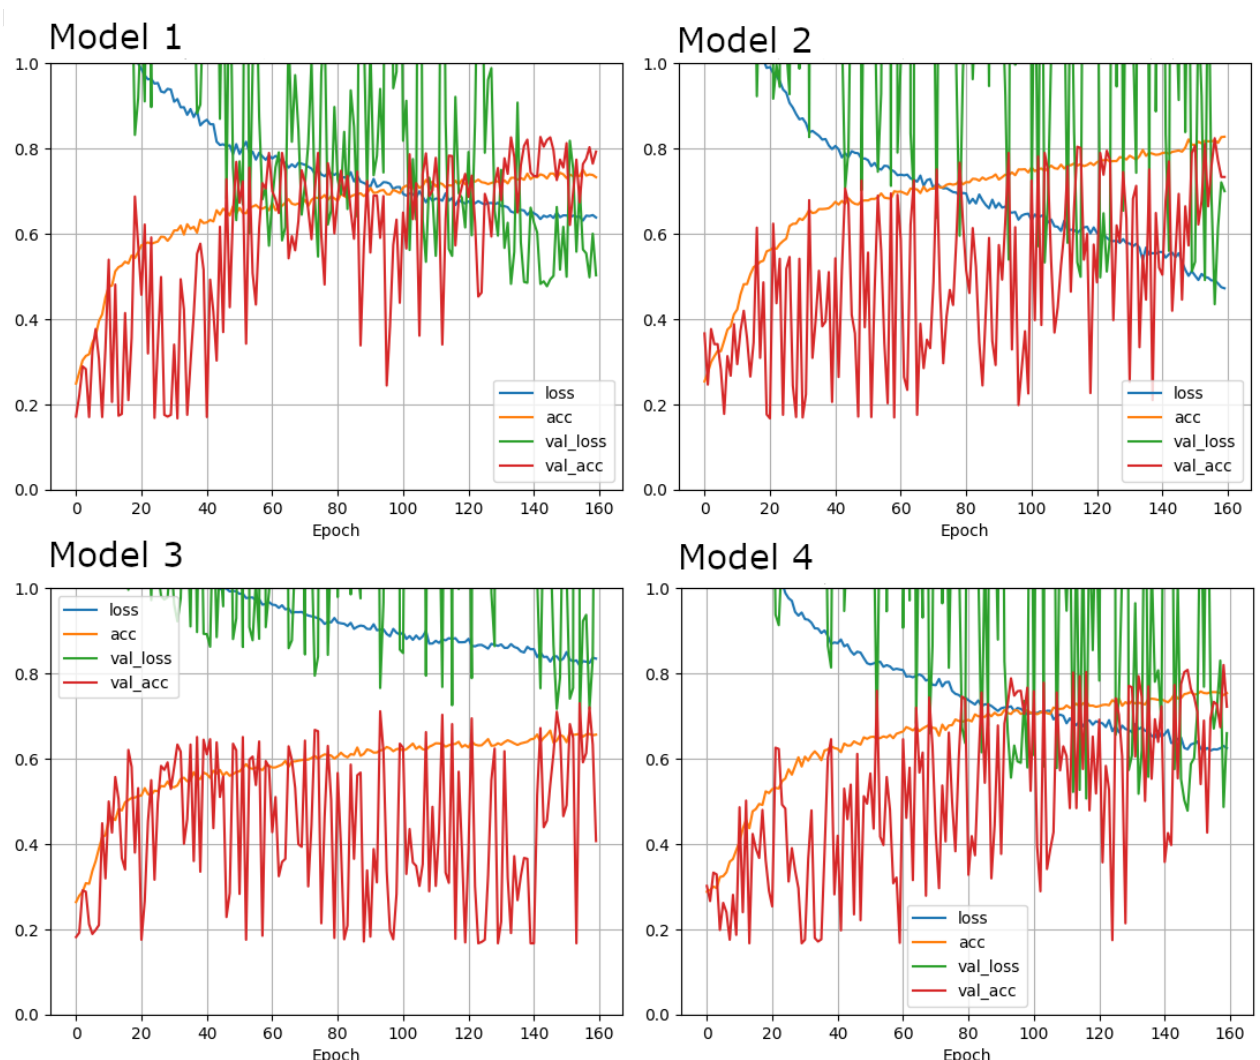
Figure 2. Training and validation accuracy and loss curves for the 4 different deep learning configurations. Model 1: Adam optimizer, Model 2: low resolution, Model 3: SGD optimizer and Model 4: cropped image. Highest accuracy was reached by Model 2. Table 3. Confusion matrices of the “real - world” dataset compared to the assessment of the radiologist as the ground -truth. Numbers in bold highlight the correctly assessed images.